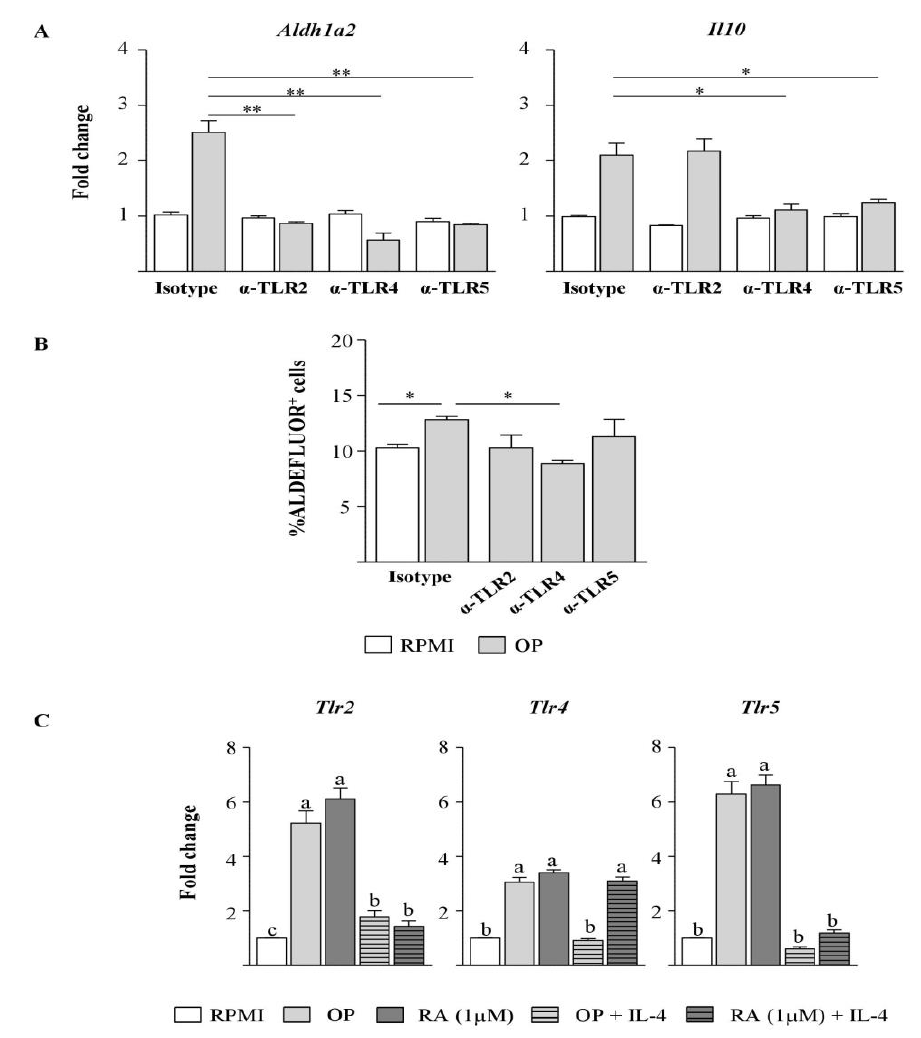
(Figure 3C), an e ff ect similarly observed on MLN-DCs (Figure S2A), while concomitant addition of IL-4 downregulated TLR genes in BM-DCs, with the only exception of RA plus IL-4 on Tlr4 (Figure 3C).